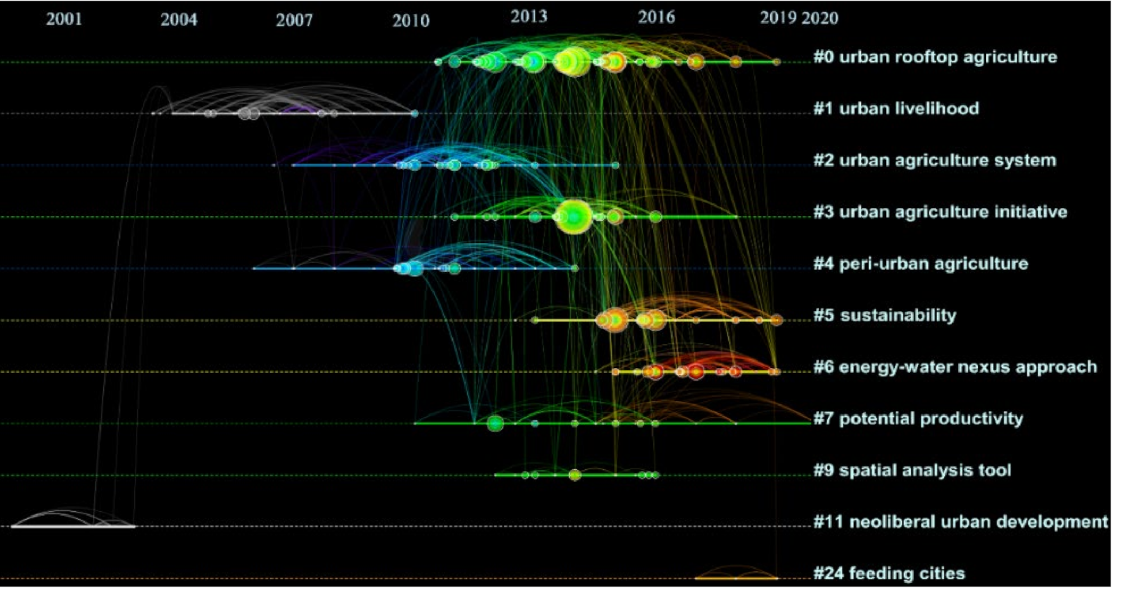
Figure 8. Timeline of clusters on urban agriculture from 2001 to